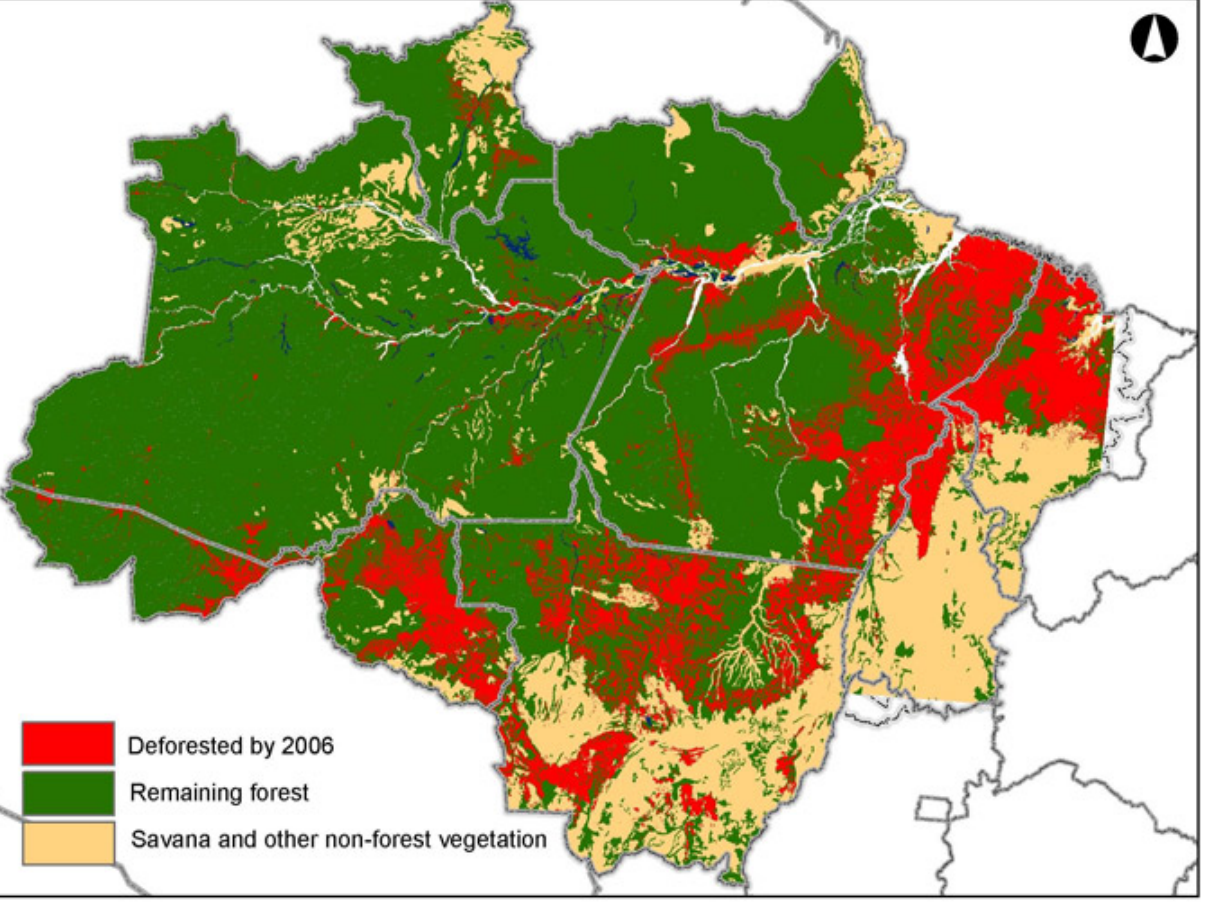
Fig. 2. Deforestation through 2006 in Brazilian Amazonia. Most of the clearing has taken place in the “arc of deforestation,” referring to the crescent-shaped area along the eastern and southern edges of the